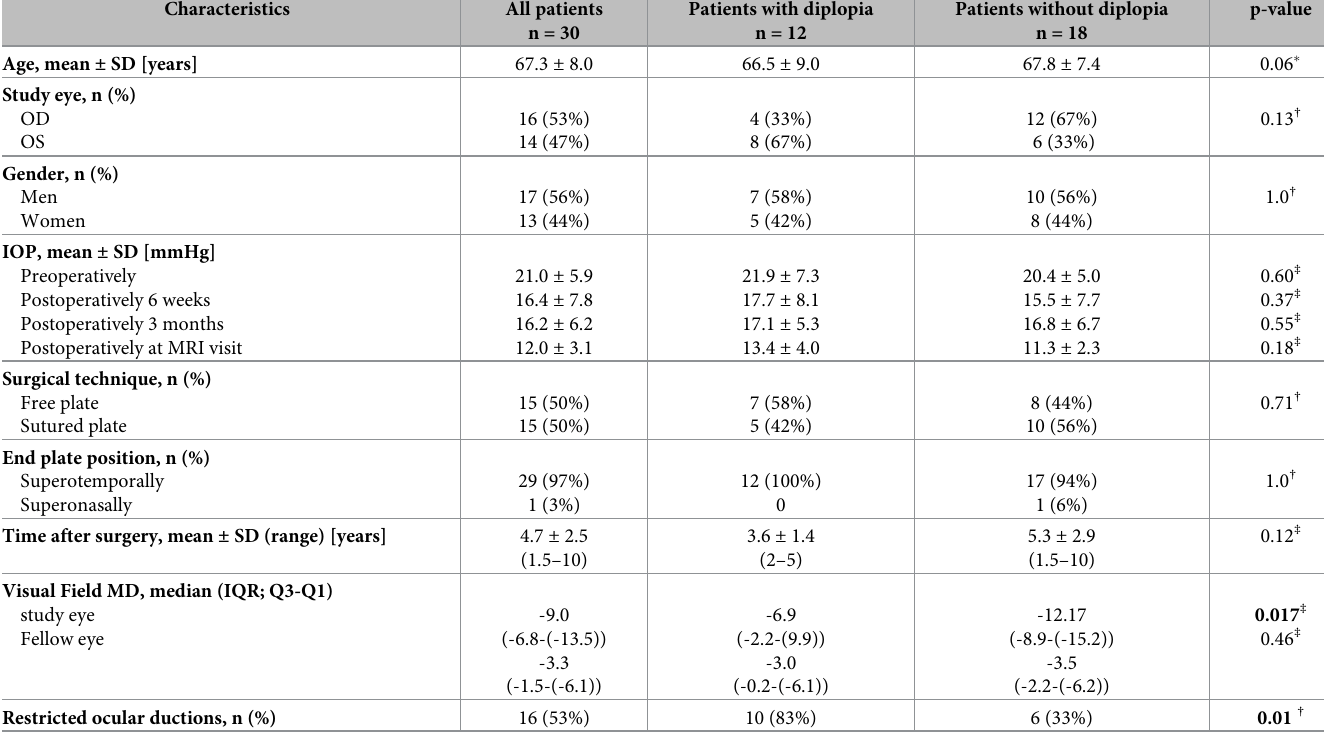
Table 1. Patient characteristics at